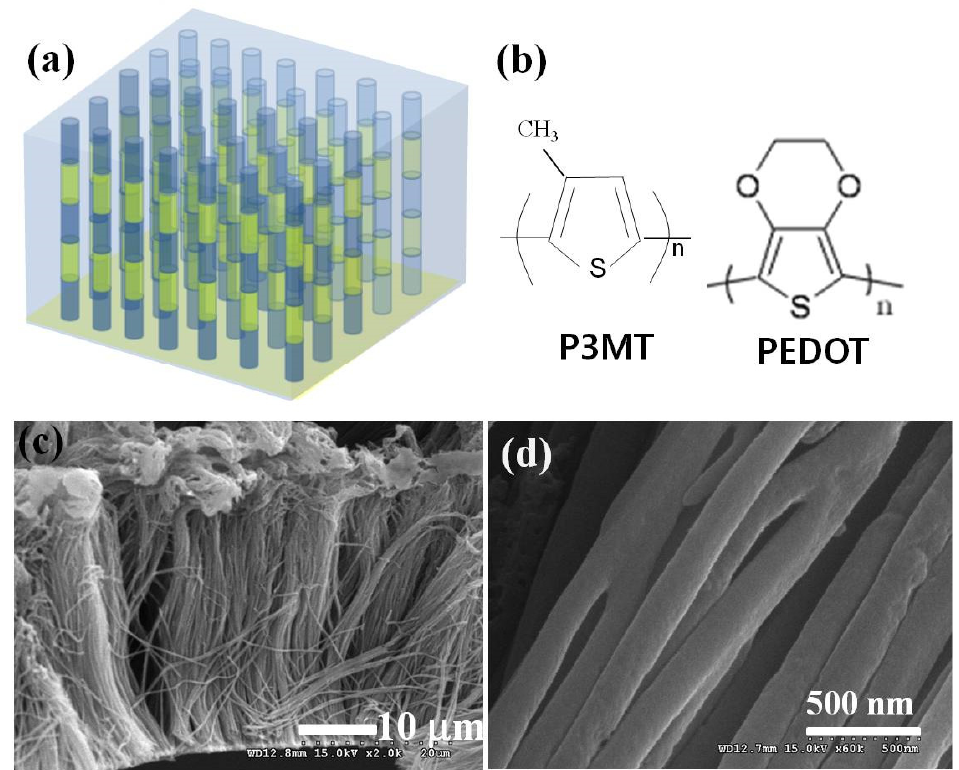
Figure 1. ( a ) Schematic illustration of luminescent organic barcode nanowires. ( b ) Molecular structures of poly(3-methylthiophene) (P3MT) and poly(3,4-ethylenedioxythiophene) (PEDOT). SEM images showing the side ( c ) and top ( d ) view of the luminescent organic barcode